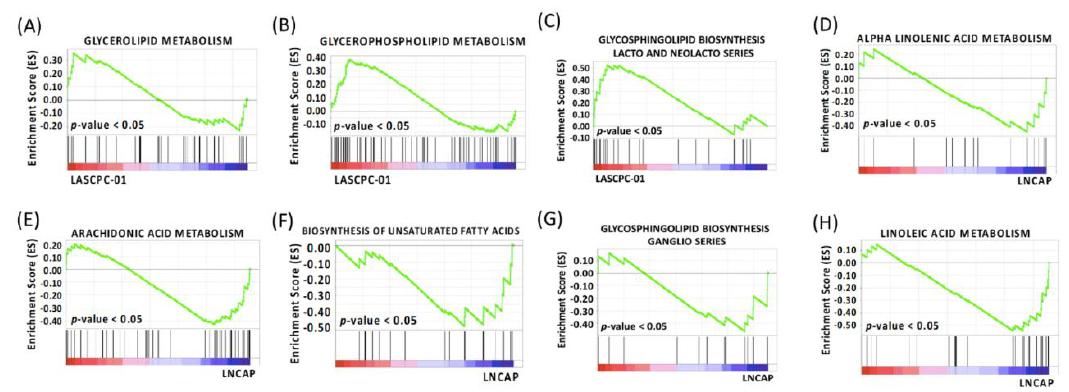
Figure 8. ( A ) GSEA plot depicting the enrichment of genes upregulated in glycerolipid metabolism in the LASCPC-01 cell line ( p -value < 0.05). ( B ) GSEA plot depicting the enrichment of genes upregulated in glycerophospholipid metabolism in the LASCPC-01 cell line ( p -value < 0.05). ( C ) GSEA plot depicting the enrichment of genes upregulated in glycosphingolipid biosynthesis lacto and neolacto series in the LASCPC-01 cell line ( p -value < 0.05). ( D ) GSEA plot depicting the enrichment of genes upregulated in alpha linolenic acid metabolism in the LNCAP cell line ( p -value < 0.05). ( E ) GSEA plot depicting the enrichment of genes upregulated in arachidonic acid metabolism in the LNCAP cell line ( p -value < 0.05). ( F ) GSEA plot depicting the enrichment of genes upregulated in biosynthesis of unsaturated fatty acids in the LNCAP cell line ( p -value < 0.05). ( G ) GSEA plot depicting the enrichment of genes upregulated in glycophingolipid biosynthesis ganglio series in the LNCAP cell line ( p -value < 0.05). ( H ) GSEA plot depicting the enrichment of genes upregulated in linoleic acid metabolism in the LNCAP cell line ( p -value < 0.05). Table 3. Upregulated gene sets in lipid metabolism in the LASCPC-01 cell line and SCNC patients. LASCPC-01 SCNC Gene Sets